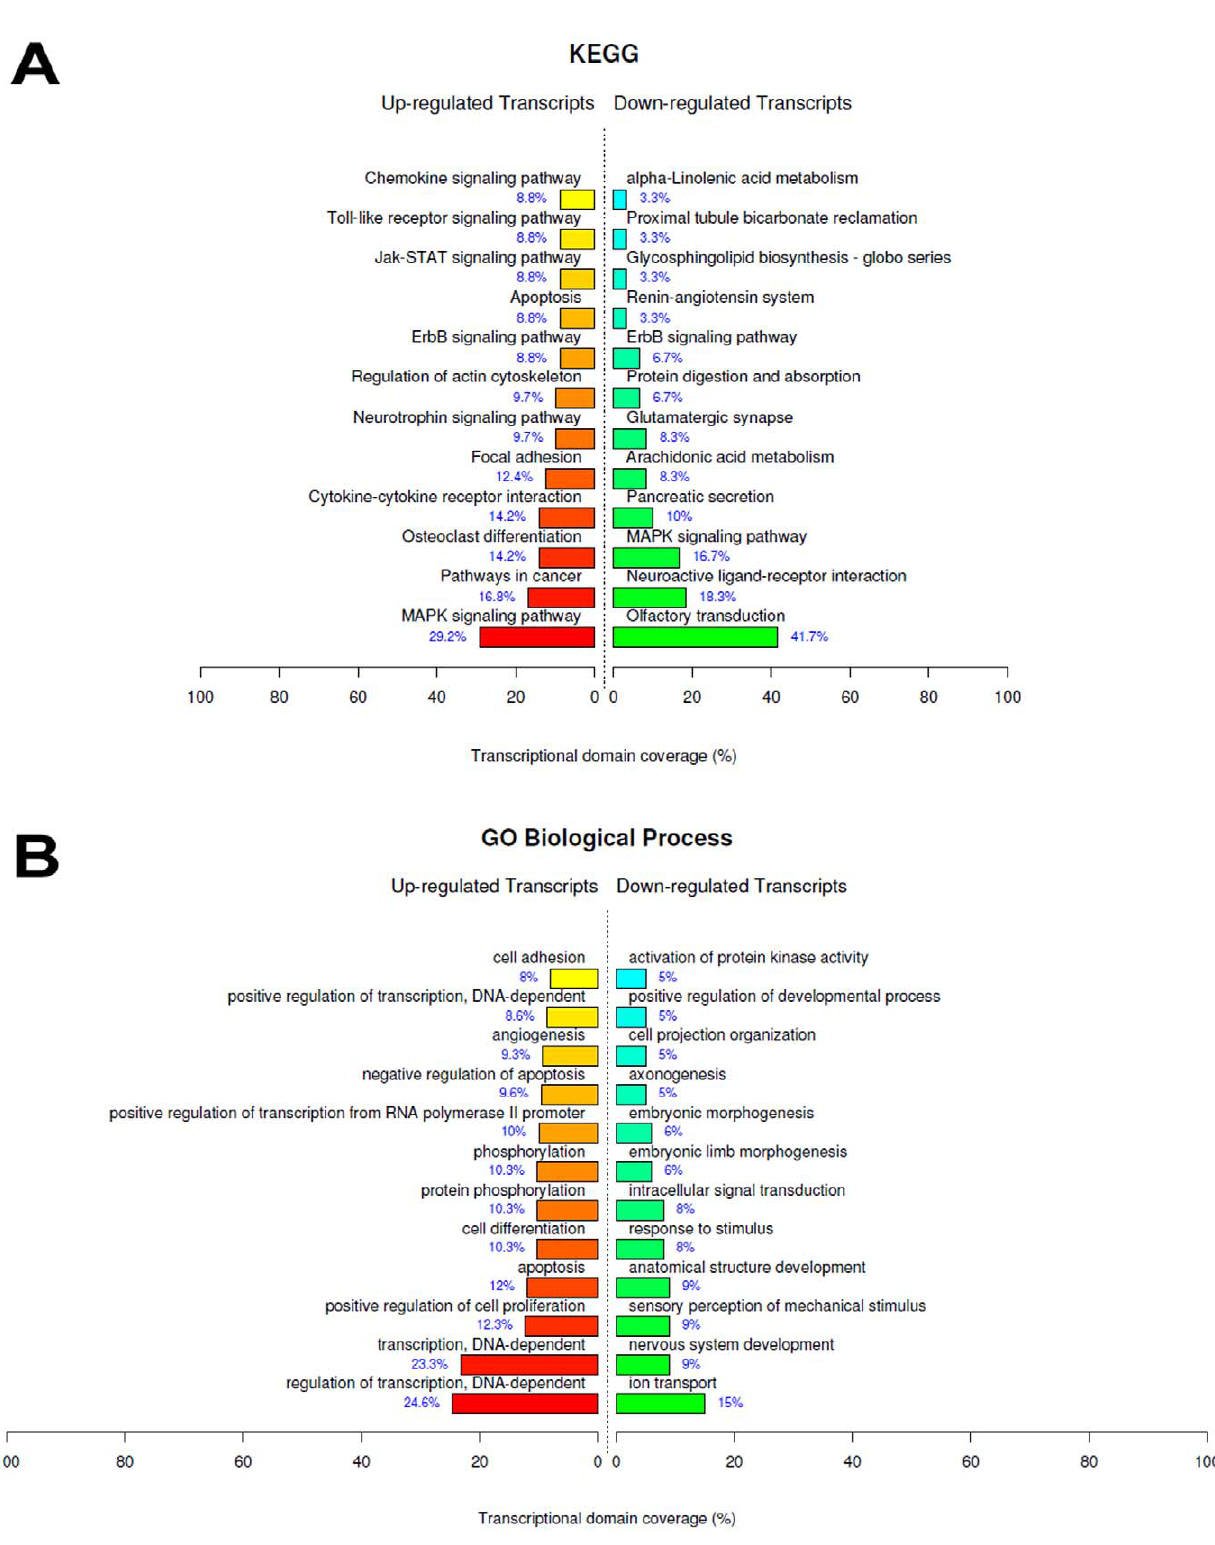
PLOS ONE | www.plosone.org